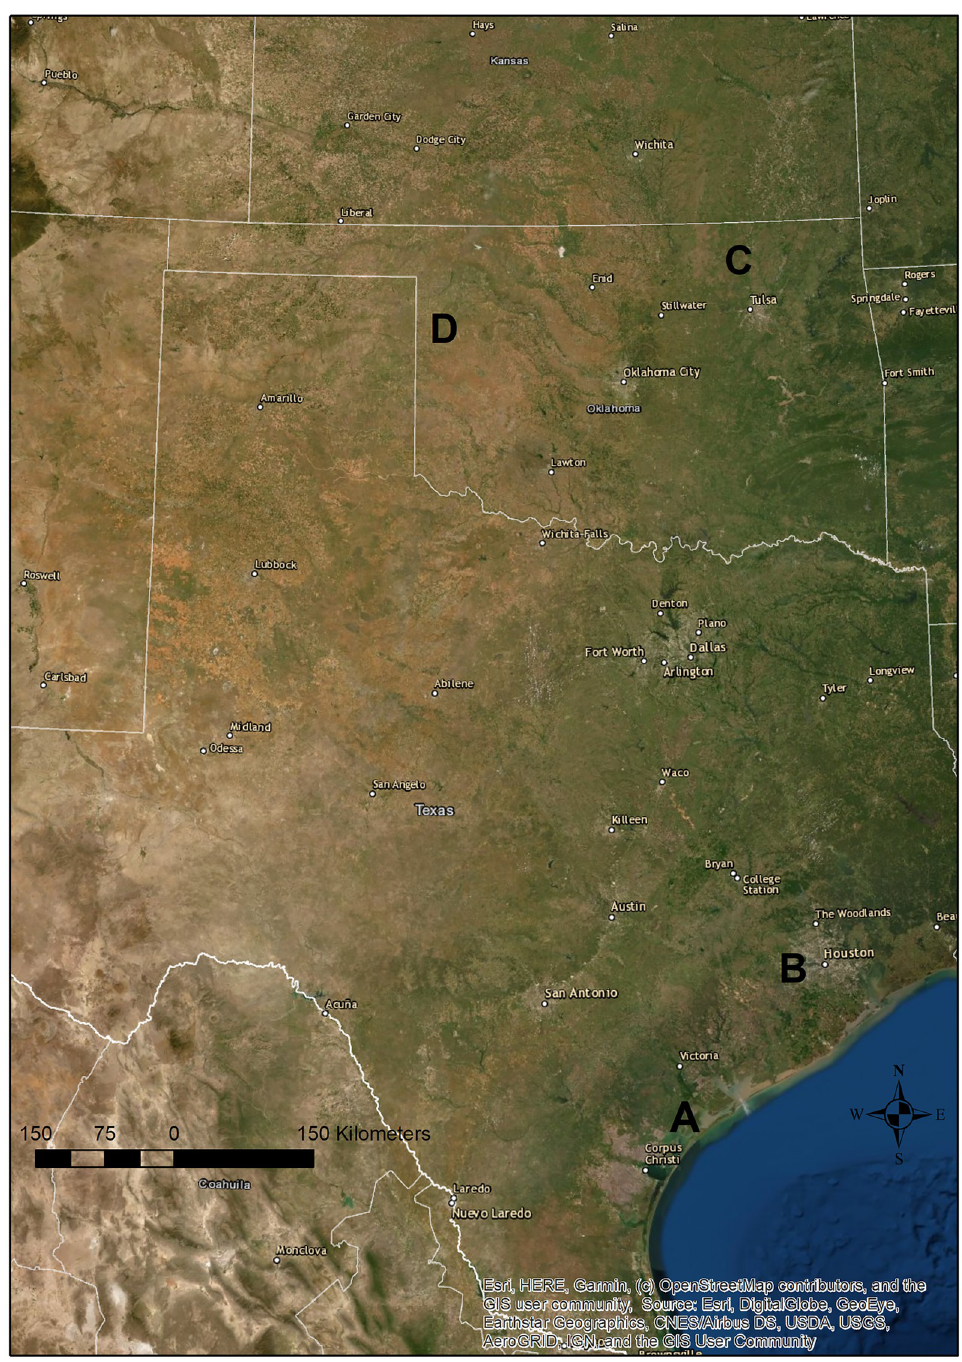
Fig 1. Study site map. Map showing approximate locations of each study site. A = Aransas National Wildlife Refuge (NWR); B = Attwater’s Prairie-chicken NWR; C = Tallgrass Prairie Preserve; D = Packsaddle Wildlife Management Area.